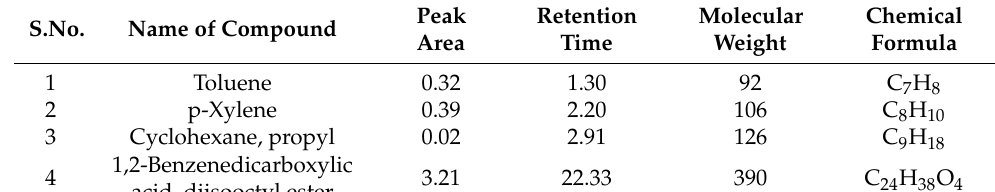
Figure 10. GC chromatogram of methyl orange dye after Pseudomonas aeruginosa degradation.